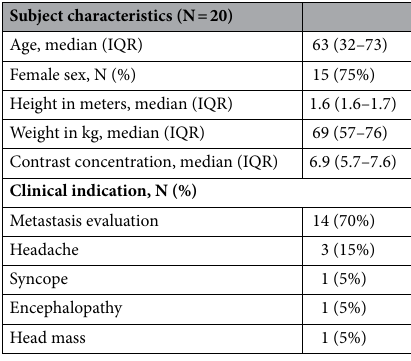
Table 1. Subject characteristics.